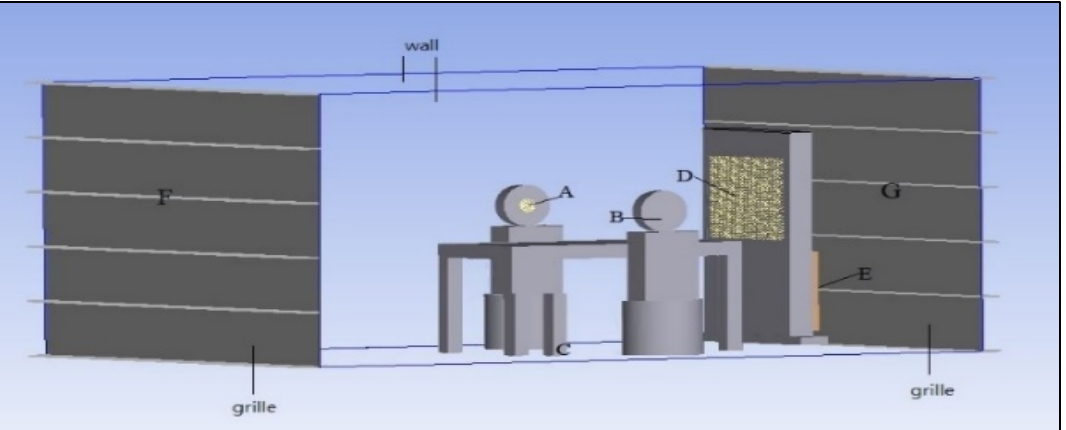
Figure 6. Air purifier in the quarantine station.